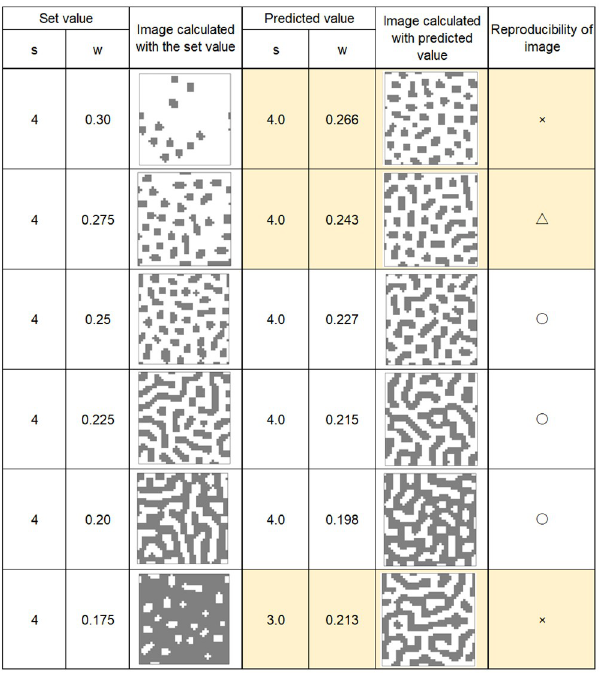
Fig 10. Calculation results (3).